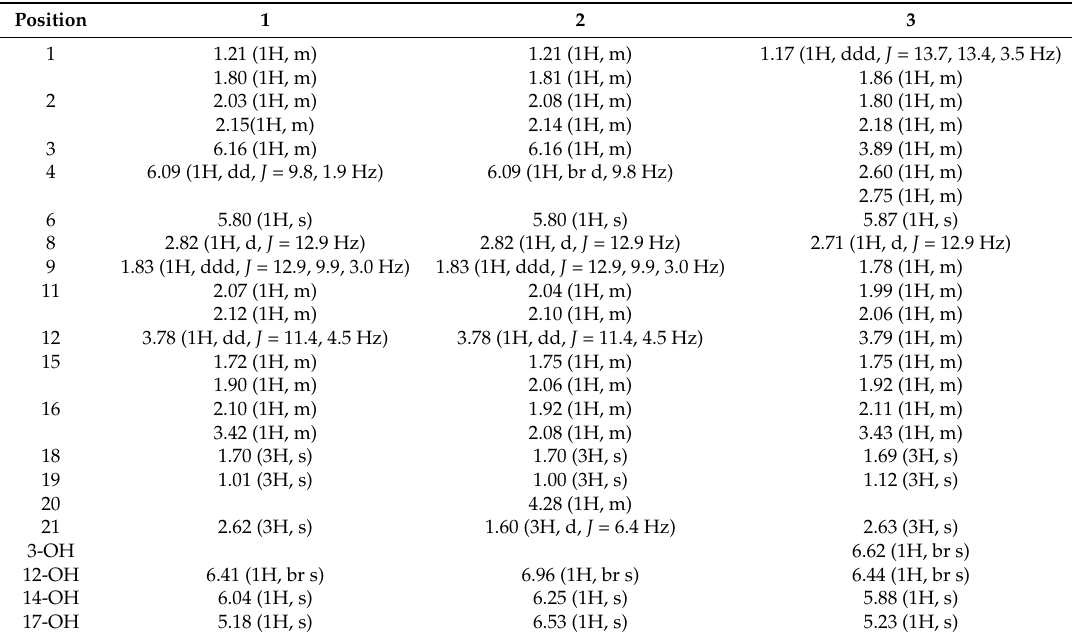
Table 2. 1 H-NMR spectral data of compounds 1 – 3 (500 MHz, C 5 D 5 N, δ in ppm). Position